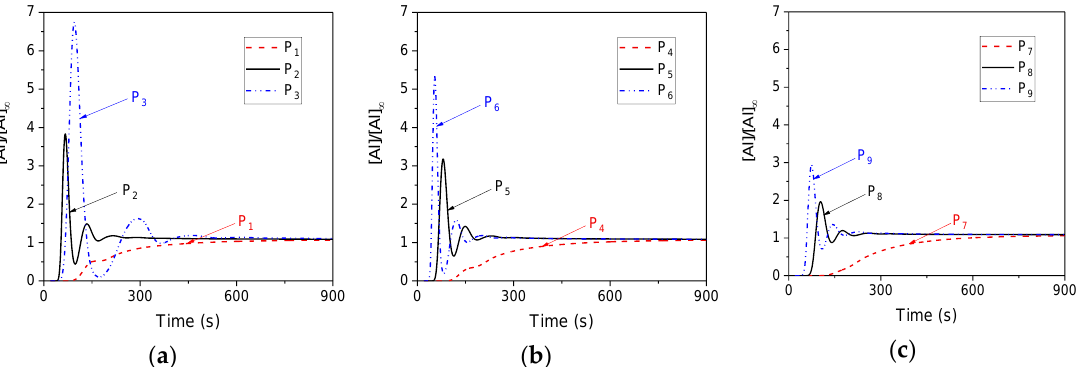
Figure 5. Positions of nine monitors.